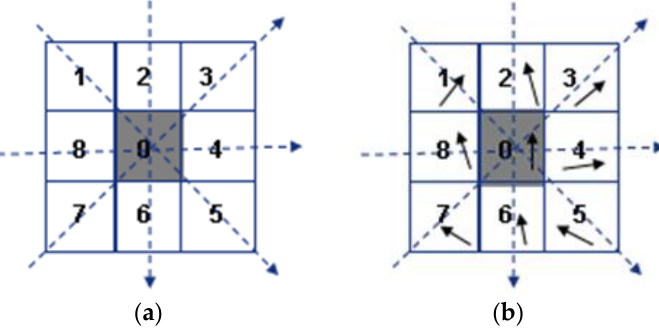
Figure 4. The two modified LBP features. ( a ) M-LBP; ( b ) O-LBP.